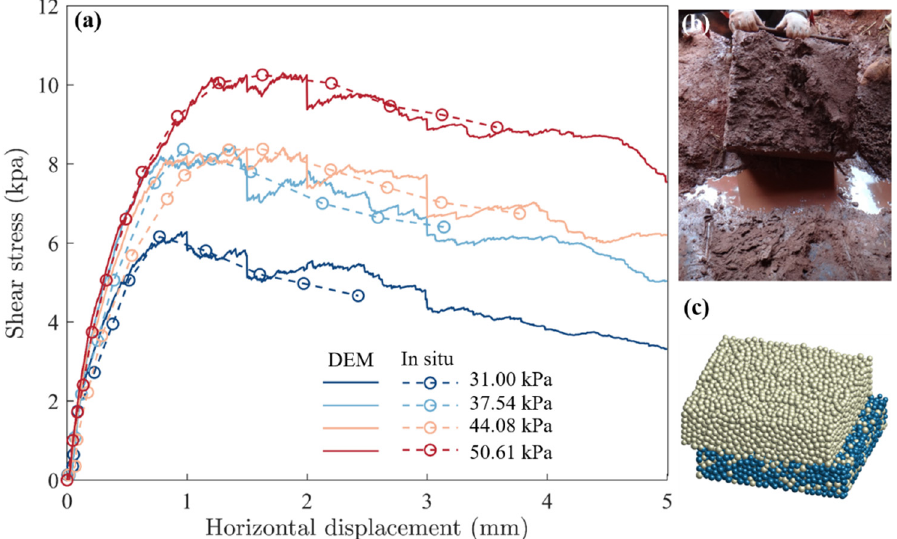
Figure 9. Comparison between the in situ tests and DEM simulations of horizontal stress– displacement curves. ( a ) Horizontal stress–displacement curves and samples after shear failure of ( b ) in situ test [9] and ( c ) discrete element test.